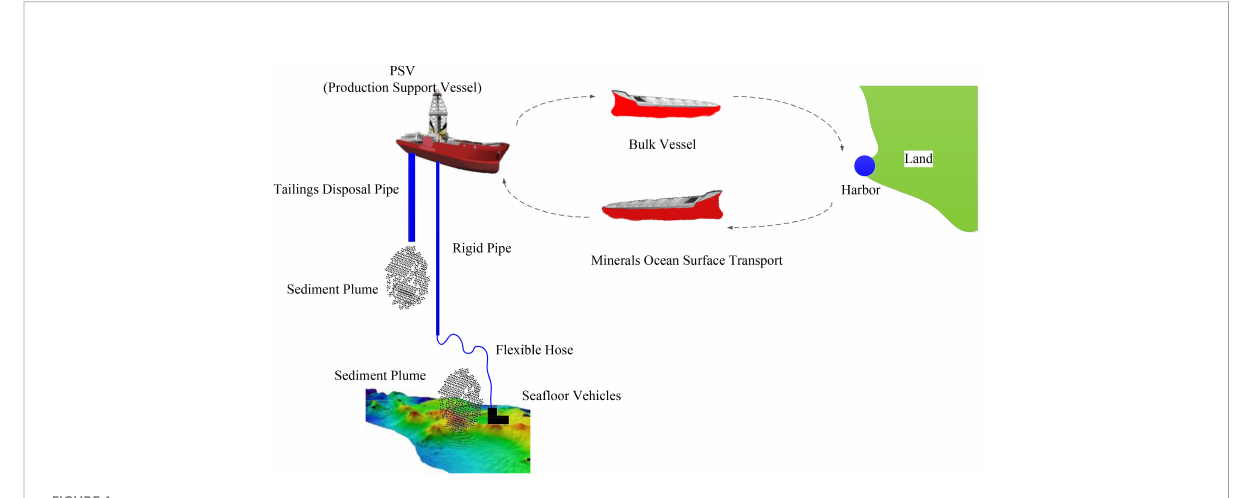
FIGURE 1 Graphic representation of an example DSM project (Ma et al.,